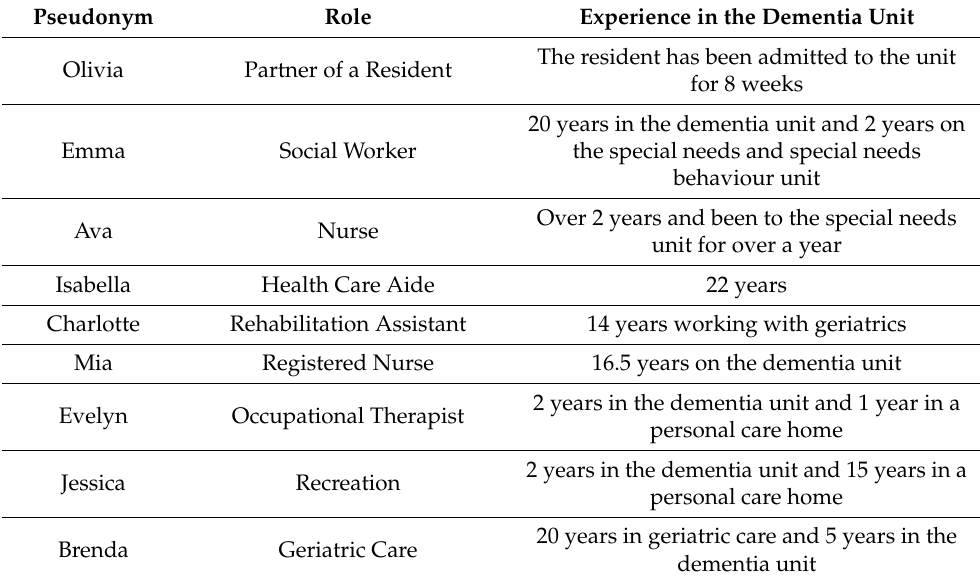
Table 1. Focus group participants’ characteristics.